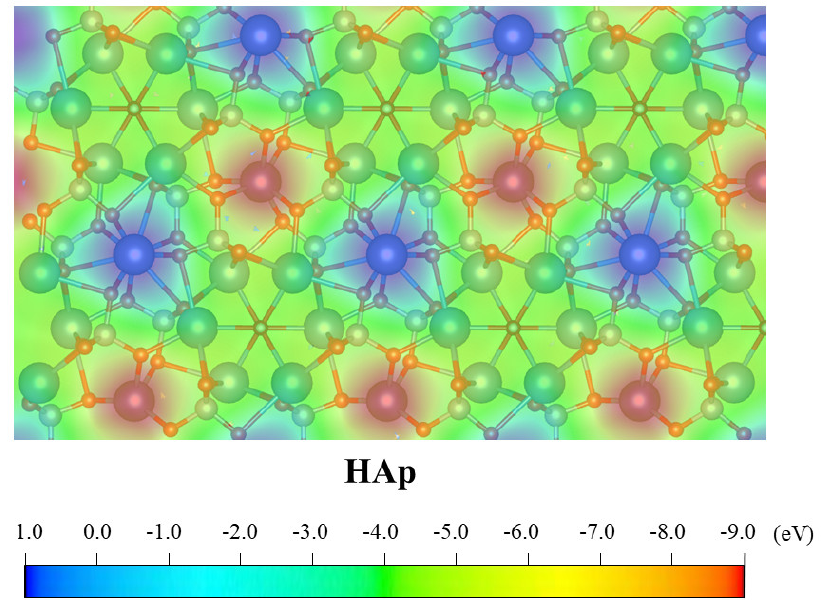
Figure 1. ESP of HAp. The blue area represents a positive ESP exhibiting electrophilic properties, whereas the red area represents a negative ESP exhibiting nucleophilic properties.